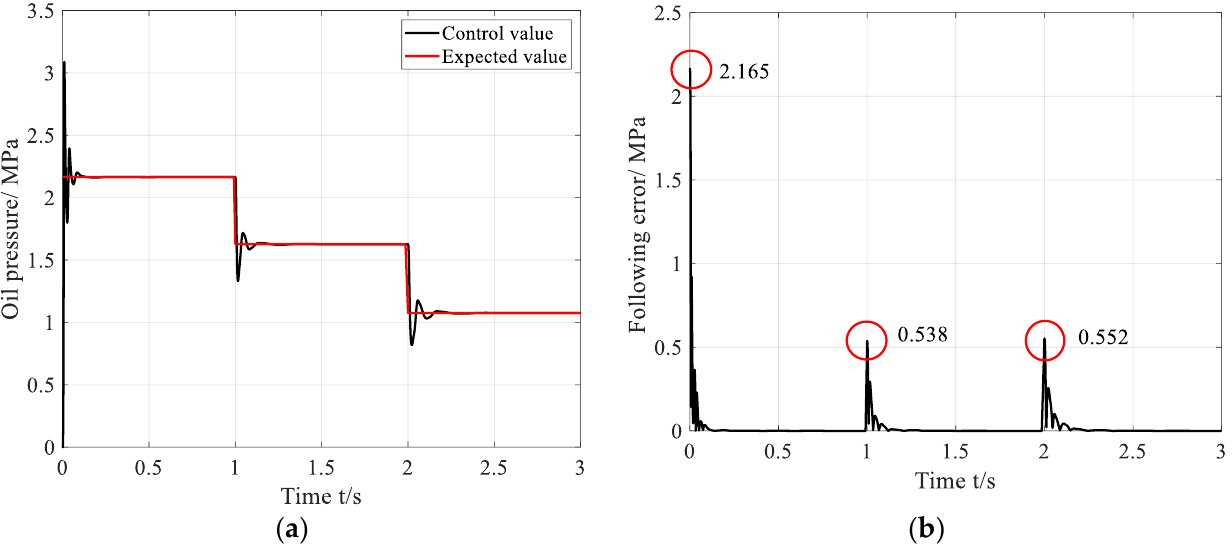
Figure 6. Square wave signal following control of oil pressure controller based on the backstepping algorithm. ( a ) Target oil pressure; ( b ) following error.